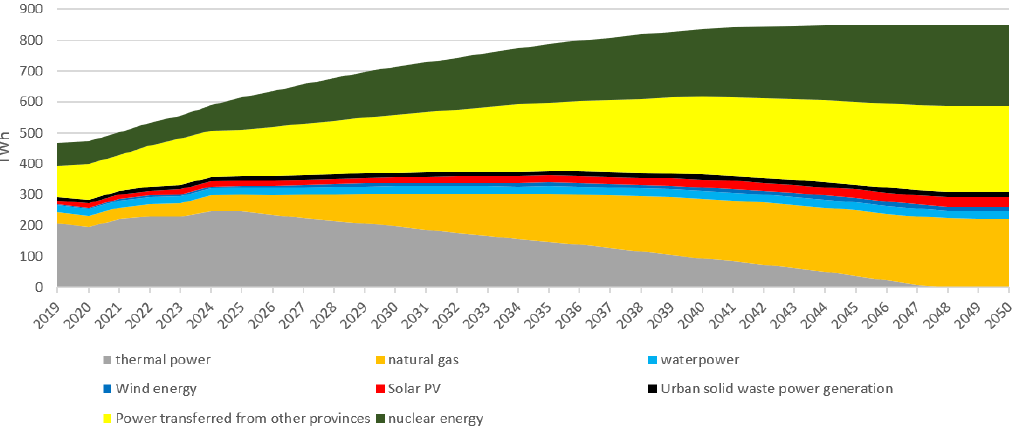
Figure 15. Power generation change in Zhejiang Province under the scenario of early retirement of coal power units.